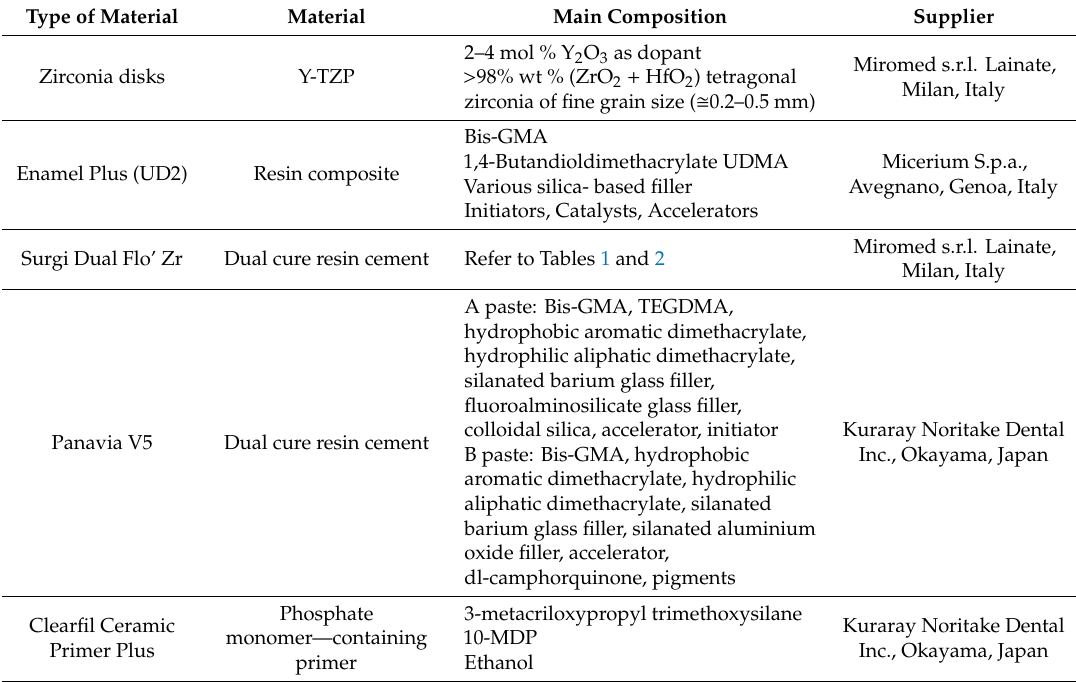
Table 3. List of materials used for the experimental phase of